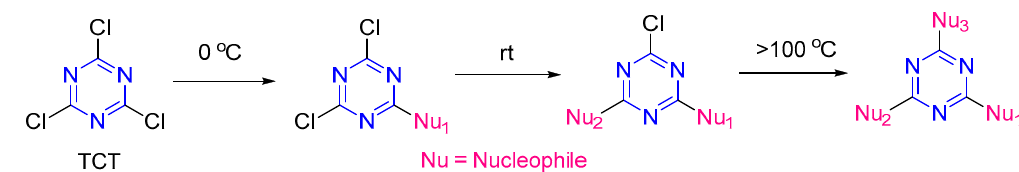
Figure 1. 2,4,6-Trichloro-1,3,5-triazine (TCT) reactivity toward the nucleophilic substitution reaction.